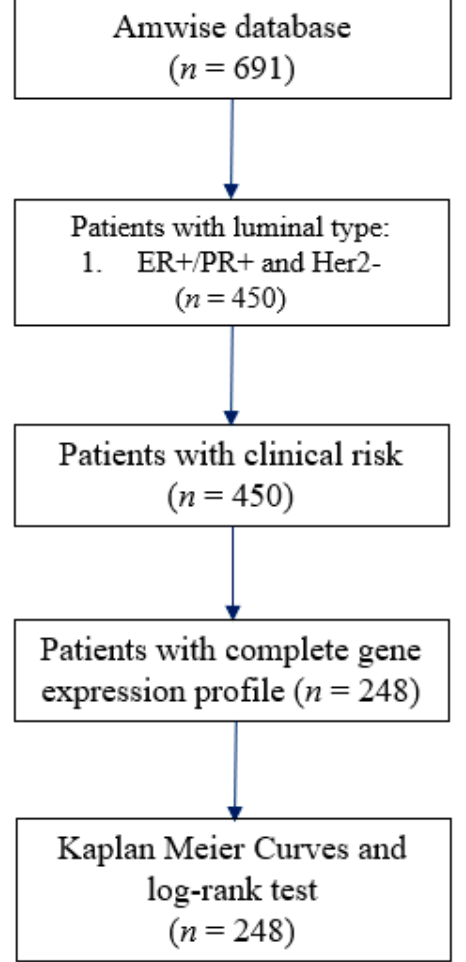
Figure 1. Consolidated standard of reporting trials (CONSORT) for this study to perform the work- flow of this